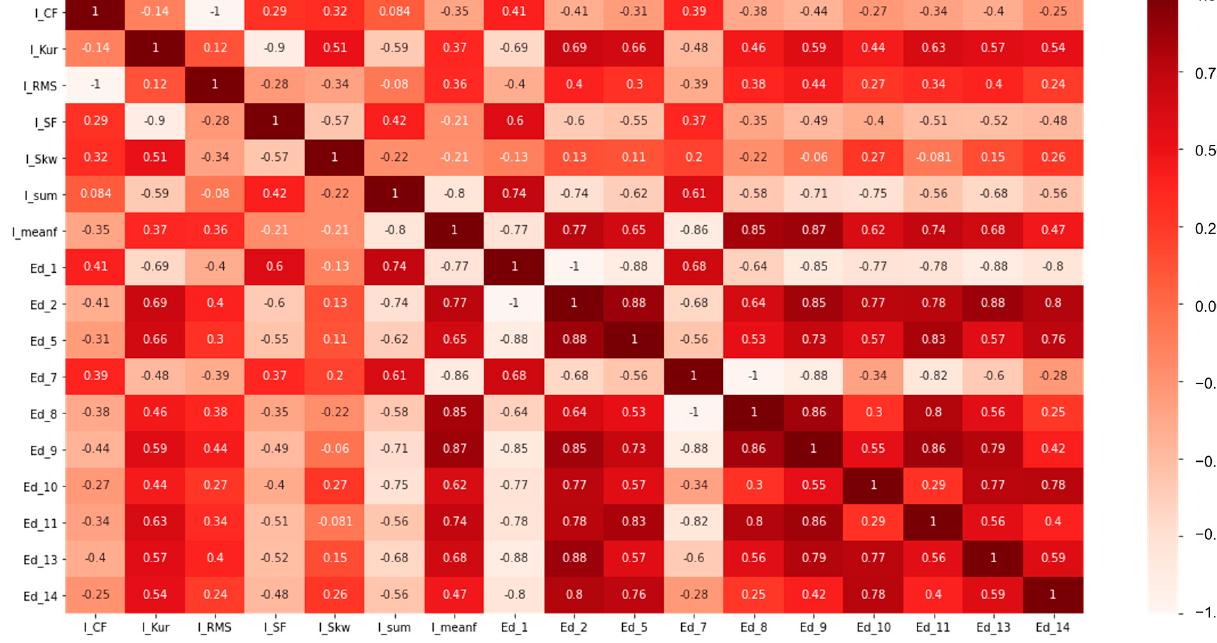
Figure 13. Features selected by removing one of the features whose correlation coefficient exceeds the r value.